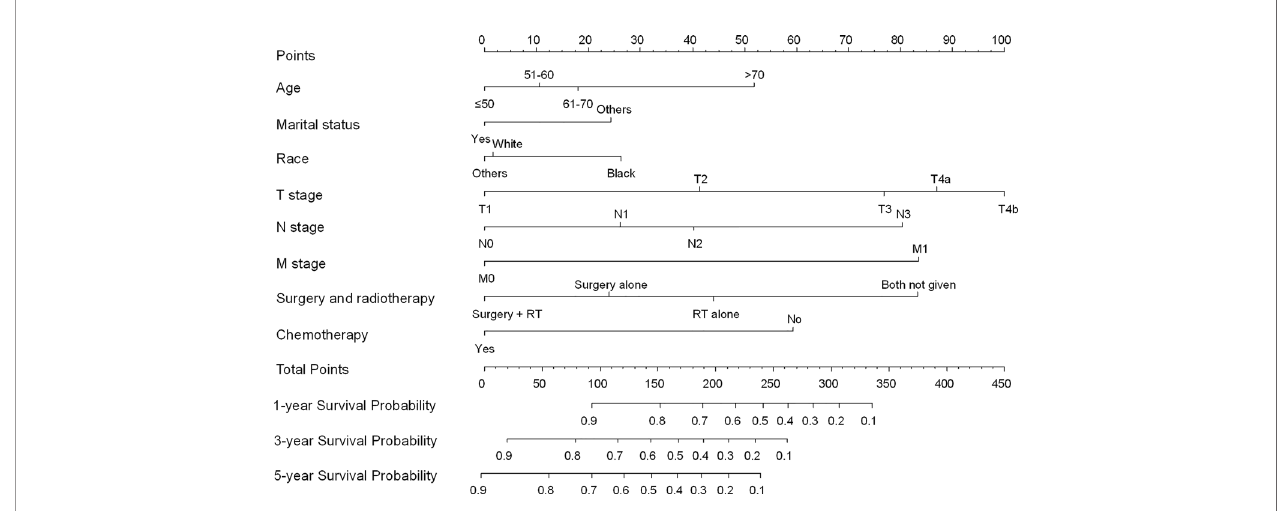
FIGURE 4 | Nomogram for predicting the survival probability of HSCC patients.